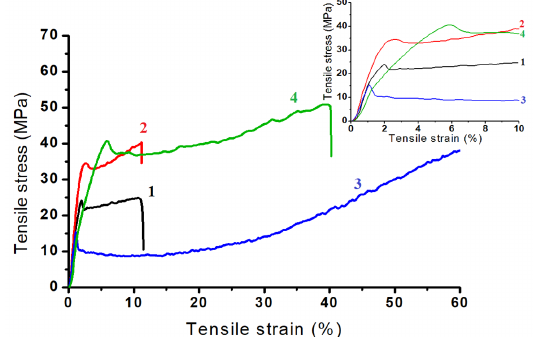
Figure 4. TG/DTG curves of CS-TS , CS-TS-HS , CS-TS-TPP, and CS-TS-PDMS composite membranes compared with pristine chitosan (CS).